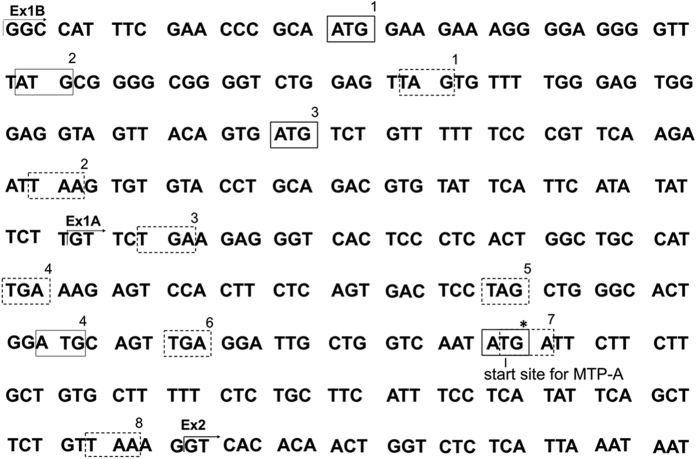
Nucleotide sequence for exons 1B and 1A.Start (boxes with solid lines) and stop (boxes with dashed lines) codons in the 5′-UTR of MTP-C are highlighted. Start sites ATG-1 and -3 are in frame with TGA-4; ATG-2 is in frame with TAG-1; ATG-4 is in frame with a stop codon at the end of exon 1A (TAA-8). ATG* denotes translation initiation site for MTP-A.